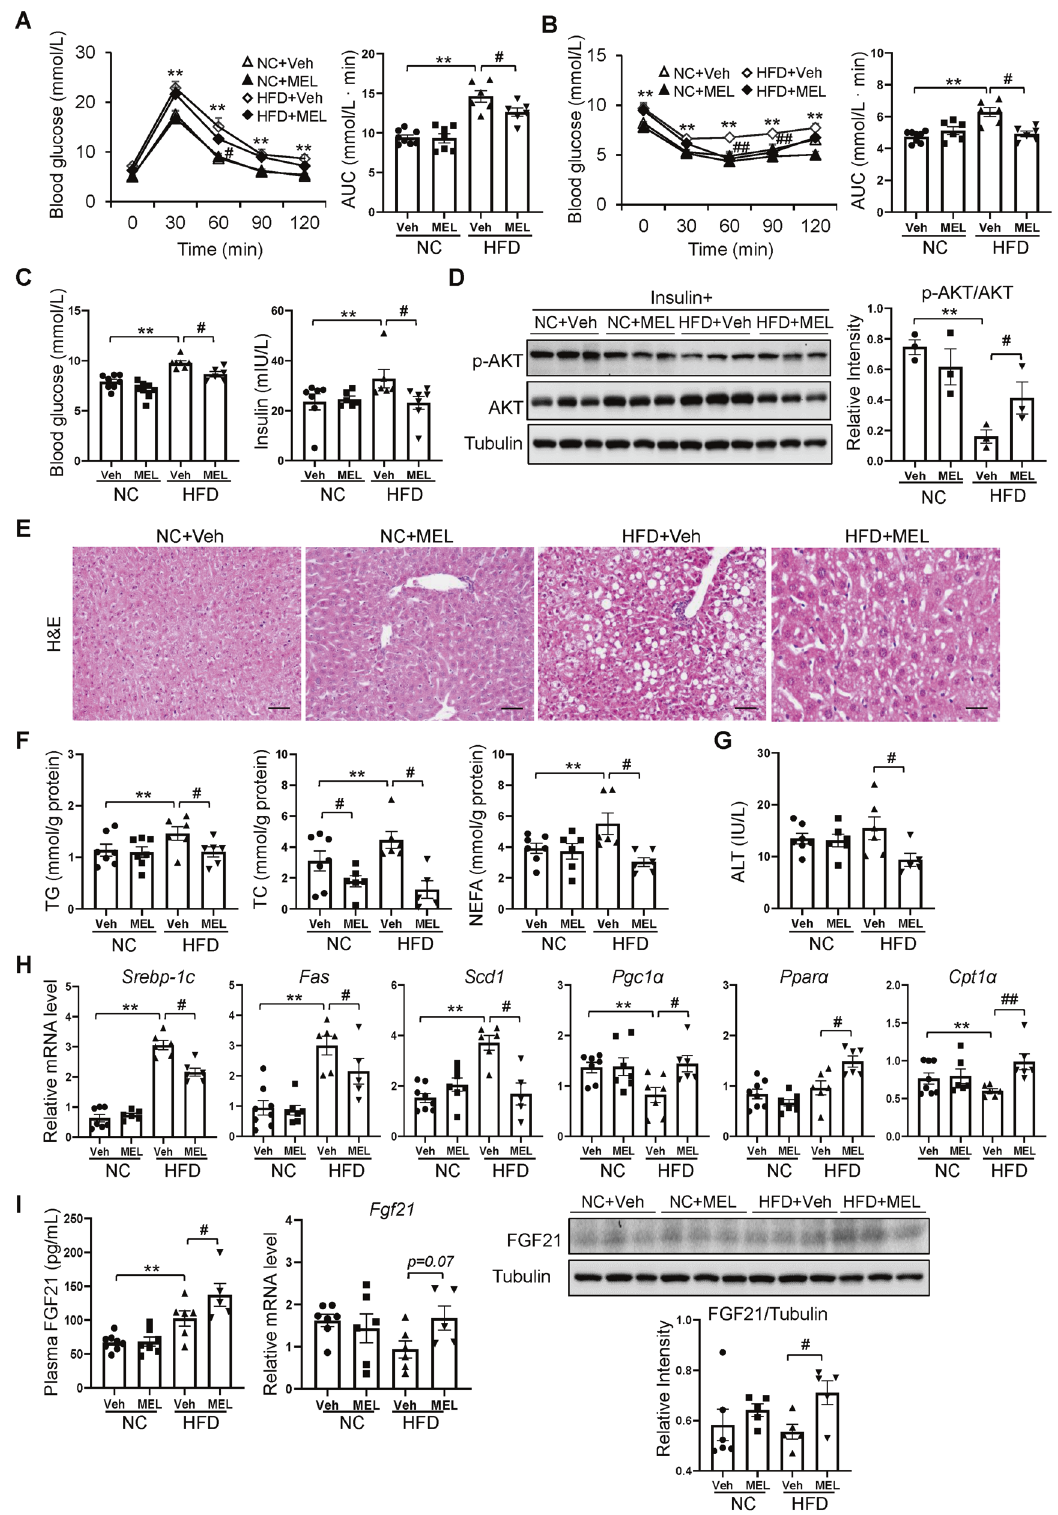
Fig. 6 Melatonin ameliorates HFD-induced insulin resistance and hepatic steatosis. A Glucose tolerance test. B Insulin tolerance test. C Blood glucose and plasma insulin levels. D Immunoblots of phosphorylated Ser473 Akt (p-Akt) and Akt in the liver. E H&E-stained liver sections. Scale bars = 100 μ m. F Hepatic lipid levels. G Plasma ALT content. H mRNA levels of lipogenesis-related and fatty acid oxidation- related genes in the liver. I The levels of FGF21 in plasma and liver of mice. Data are mean ± SEM, n = 5 – 8. Signi fi cance was determined by one-way ANOVA. *p < 0.05, **p < 0.01 vs. NC + Veh mice; # p < 0.05, ## p < 0.01, vs. HFD + Veh mice. AUC area under curve, TG triglyceride, TC total cholesterol, NEFA non-esteri fi ed fatty acid, ALT alanine